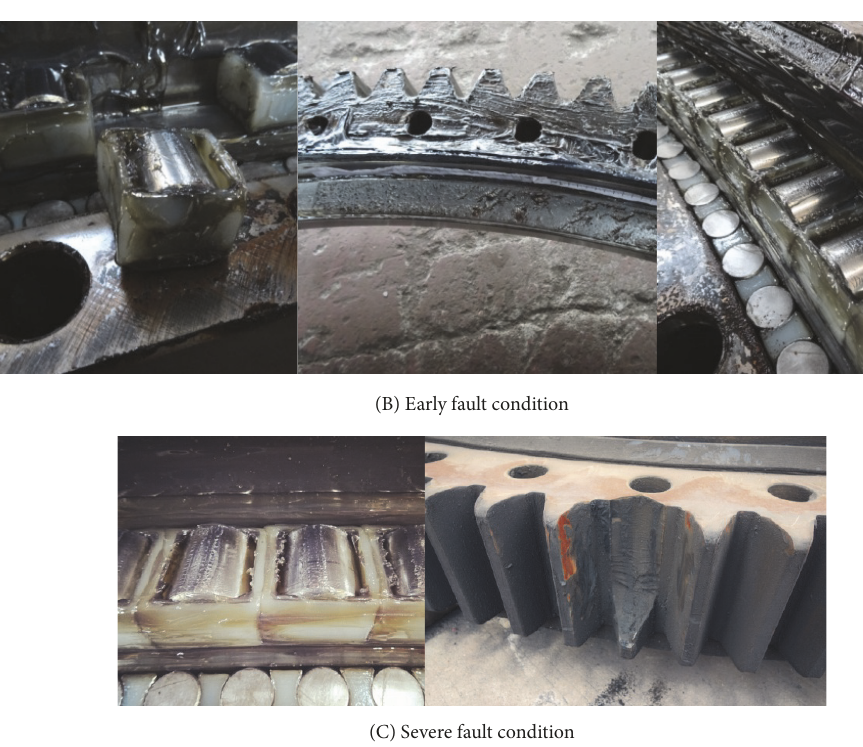
Figure 4: Faults of various conditions.